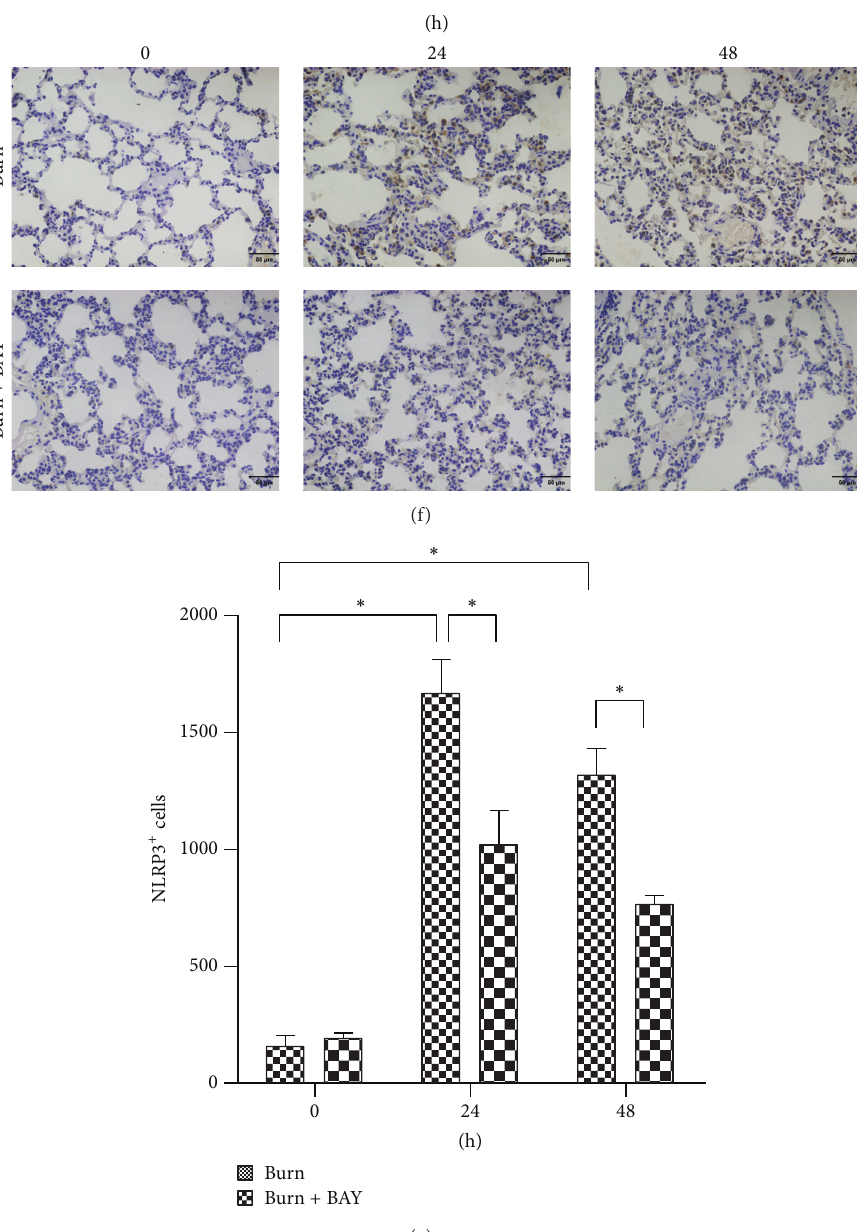
Figure 3: NLRP3 inflammasome inhibitor BAY11-7082 attenuated burn-induced NLRP3 activation in lungs. Rats were subjected to burn injury. BAY11-7082 was administered intraperitoneally immediately after burn injury in rats. At 24 h and 48 h after burn injury, lung tissue was collected. The mRNA expressions ((a) and (b)) and protein level change ((c), (d), and (e)) of NLRP3 and Caspase-1 were analyzed by real-time PCR and immunoblots in lung tissue after burn with BAY11-7082 treatment. The NLRP3 positive signal was determined by immunohistochemistry (f) and was quantified (g) in (f) per mm 2 in lung tissue after burn with BAY11-7082 treatment. The values presented are mean ± SEM ( 𝑛 = 6 per group). ∗ 𝑃 < 0.05